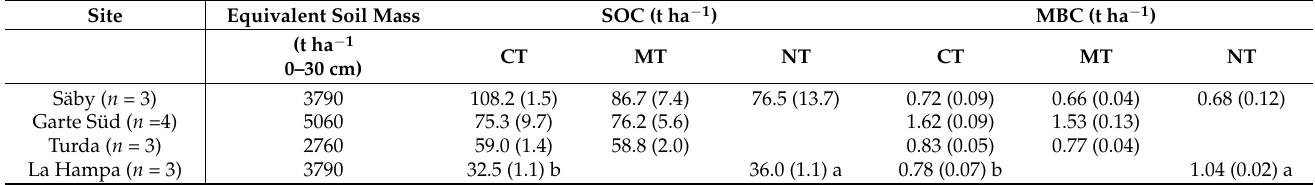
Table 3. Mean stocks (standard deviation) of soil organic carbon (SOC) and microbial biomass carbon (MBC) at the four field sites under different tillage treatments; CT = conventional tillage, MT = minimum tillage, NT = no-tillage. Information of tillage techniques are given in Table